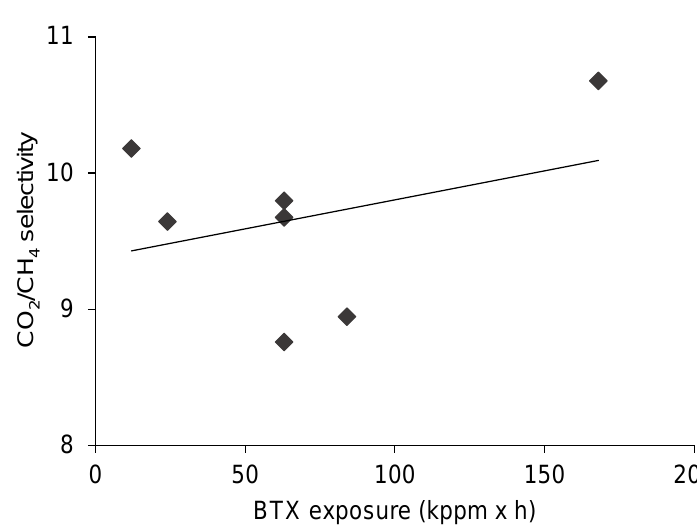
Figure 9. The e ff ect of BTX exposure on CO 2 / CH 4 selectivity. Figure 9. The effect of BTX exposure on CO 2 /CH 4 selectivity.